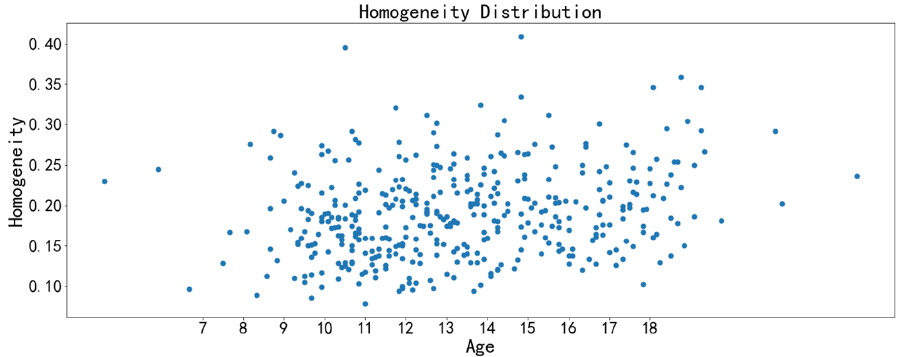
Figure 12. Scatter diagram between homogeneity with chronological age (males).